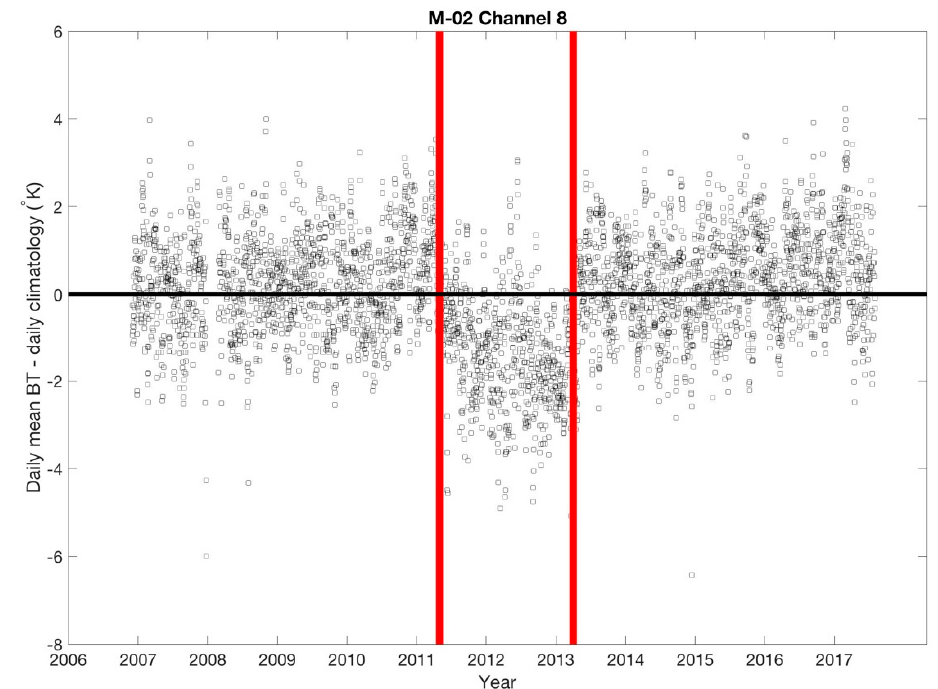
Figure 1. Anomalies of daily mean MetOp-02 high-resolution infrared radiation sounder (HIRS) channel 8 brightness temperatures as compared to a 2007–2017 climatology. Vertical red lines indicate the period of instability removed as an input to this retrieval.